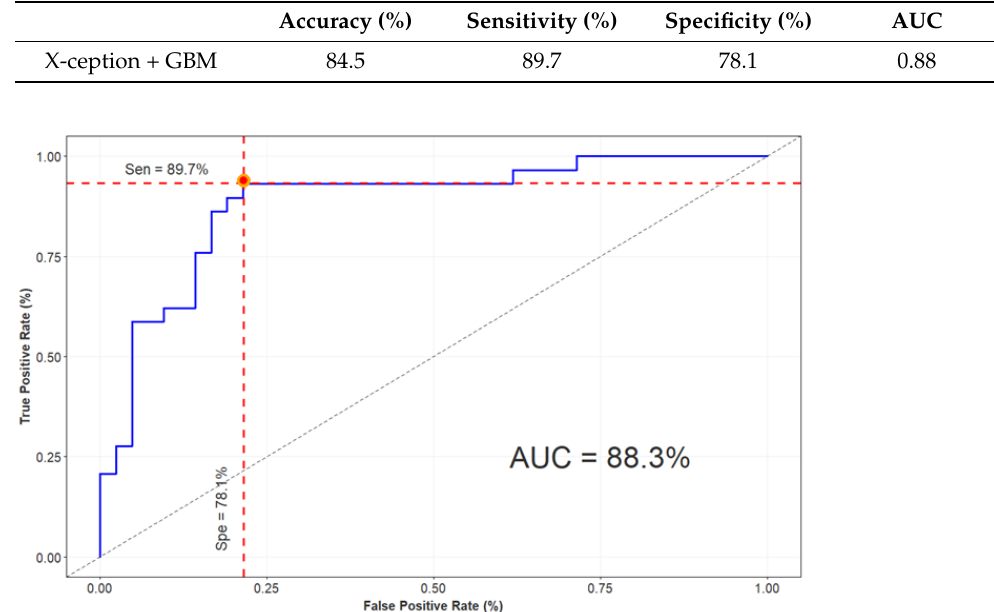
Table 5. The classification performance for the combination model.